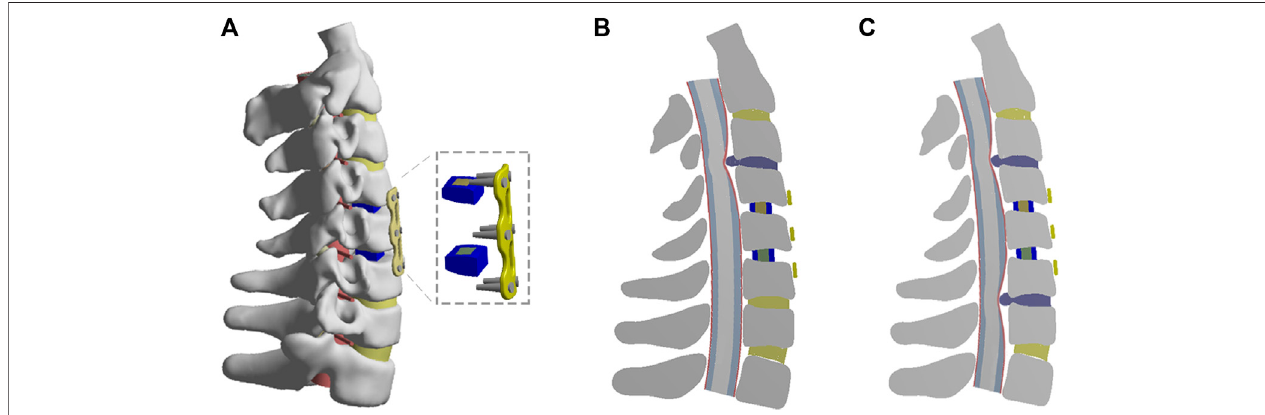
FIGURE2| TheFEmodelsofC4-C6ACDFandone-levelortwo-levelASDafterprimaryACDF. (A) TheFEmodelofC4-C6ACDF. (B) Cross-sectional viewsofthe FE model of one-level ASD. (C) Cross-sectional views of the FE model of two-level ASD.